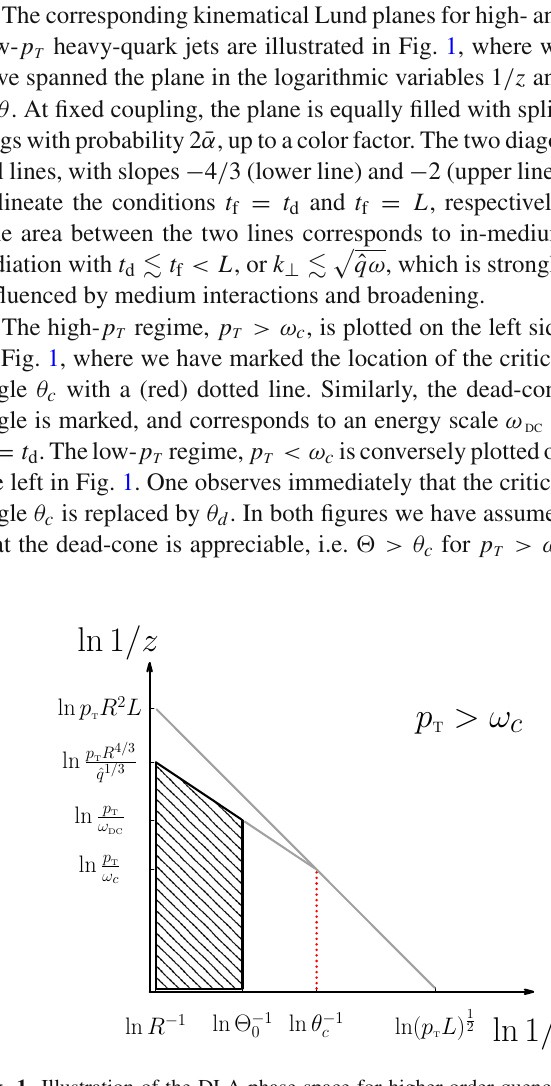
Table 1 Summary of the scales for light and heavy quarks. The char- acteristic angle for a massive quark jet is defined as the angle where (cid:2) 0 becomes equal to the minimal angle of coherence, where the quenching of a massive jet becomes different from that of a massless jet. This takes